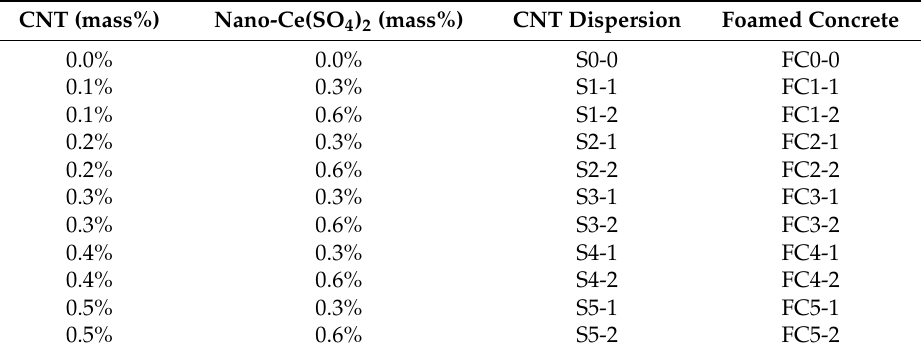
Table 2. CNT dispersion and the corresponding foamed concretes.